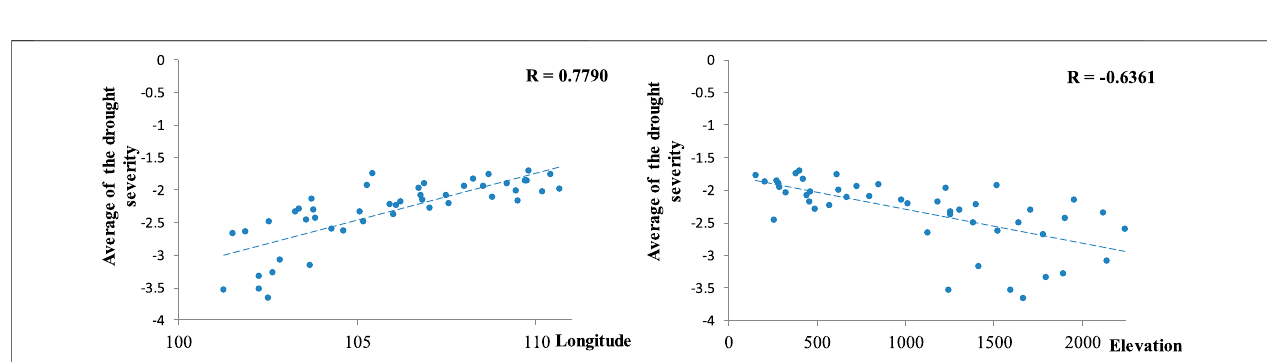
FIGURE10| Correlationsbetweenmeandroughtdurationandelevationandlongitude.Rrepresentsthecorrelationcoef fi cient,andtheboldfontsindicatethatthe con fi dence level is α (cid:1) 0.001.